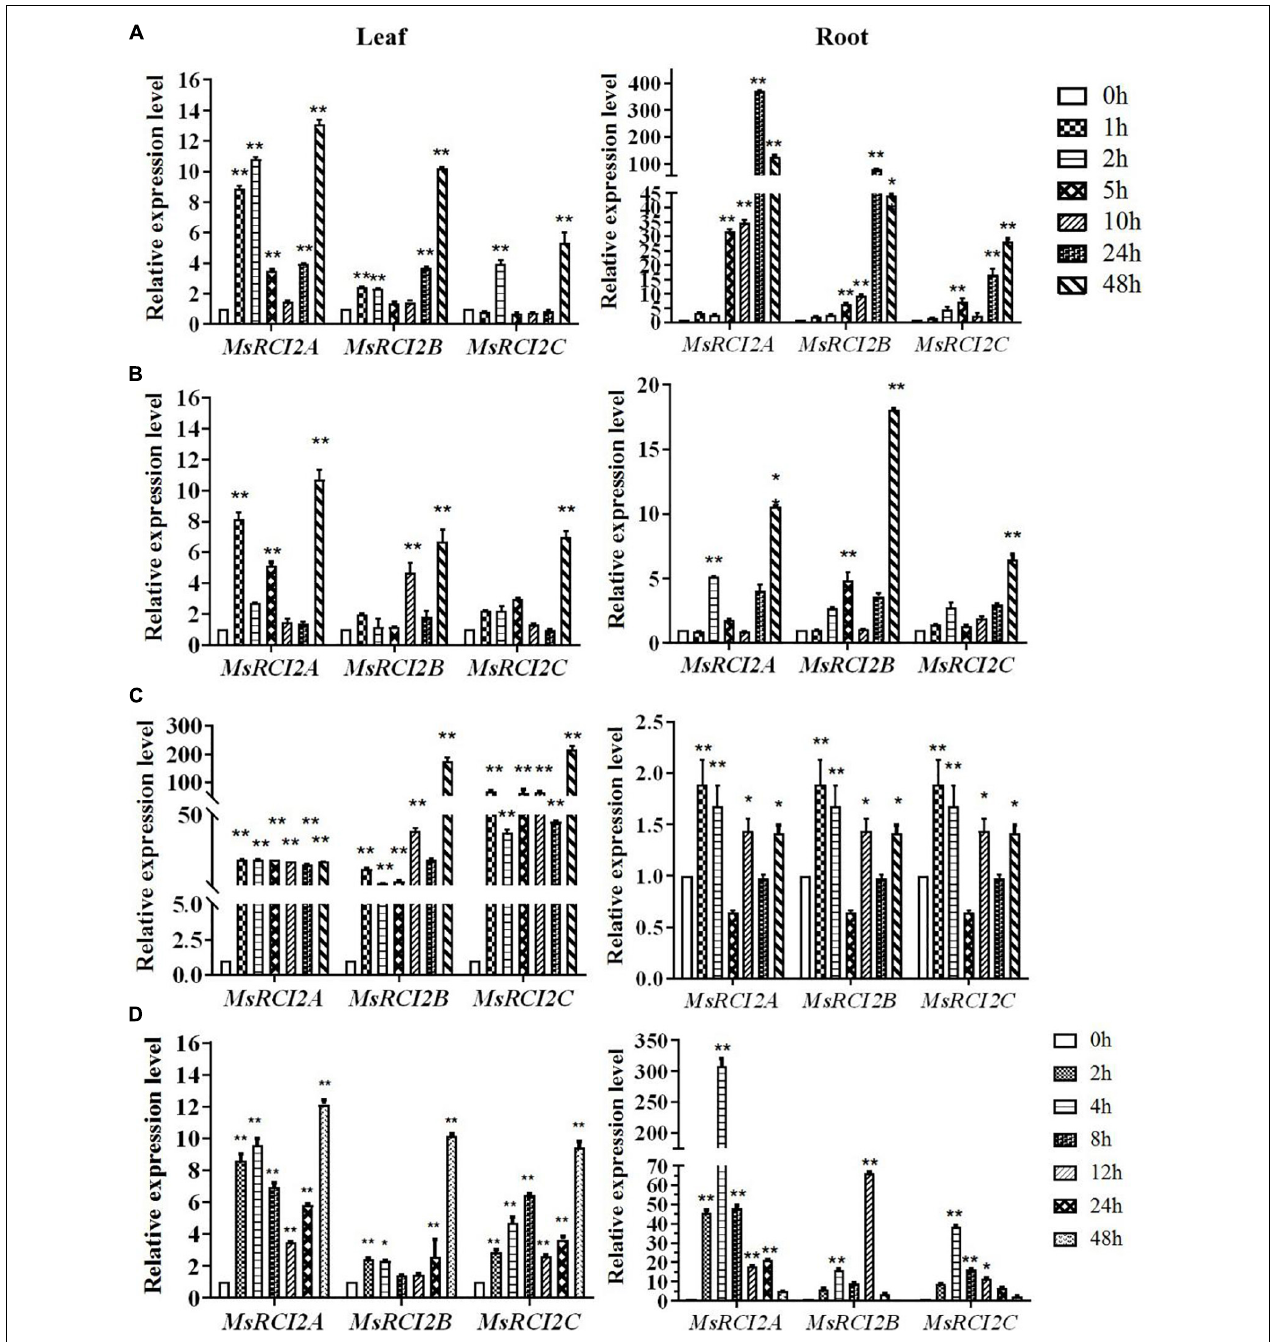
FIGURE 1 | Relative expression of the MsRCI2 genes under abiotic treatment: (A) 100 mmol.L − 1 NaHCO 3 (pH 8.5) treatment, (B) 200 mmol.L − 1 NaHCO 3 (pH 8.5) treatment, (C) 200 mmol.L − 1 NaCl treatment, and (D) 100 µ mol.L − 1 ABA induction. The figure on the left shows the expression changes in genes in the leaves; the figure on the right shows those in the roots. The values are the means ± SDs of three replicates (** P < 0.01; * P <